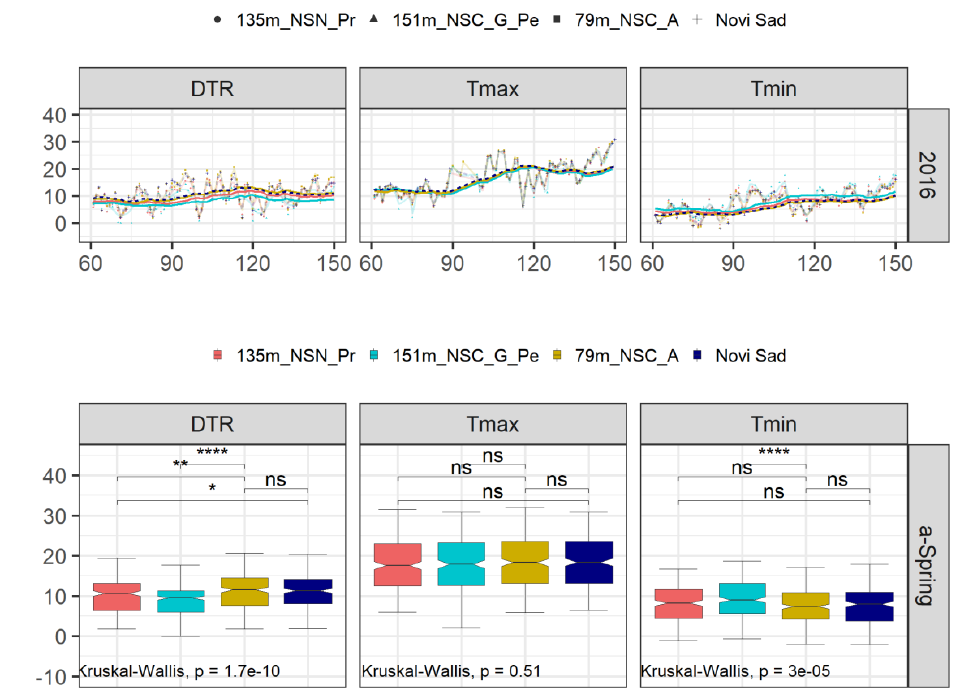
Figure 7. T max , T min , and DTR measured on the AWSs located in the pear (135m_NSN_Pr), peach (151m_NSC_G_Pe) and apple (79m_NSC_A) orchards and climatological station Novi Sad (dashed blue line) in the R1 region during the spring 2016 (sample size 91) (all years are in Supplementary S1, Figures S1.5 and S1.6). The following convention for symbols indicates statistical significance: (not significant (ns): p > 5 × 10 − 2 ), (*: p ≤ 5 × 10 − 2 ), (**: p ≤ 1 × 10 − 2 ), (****: p ≤ 1 × 10 − 4 ).